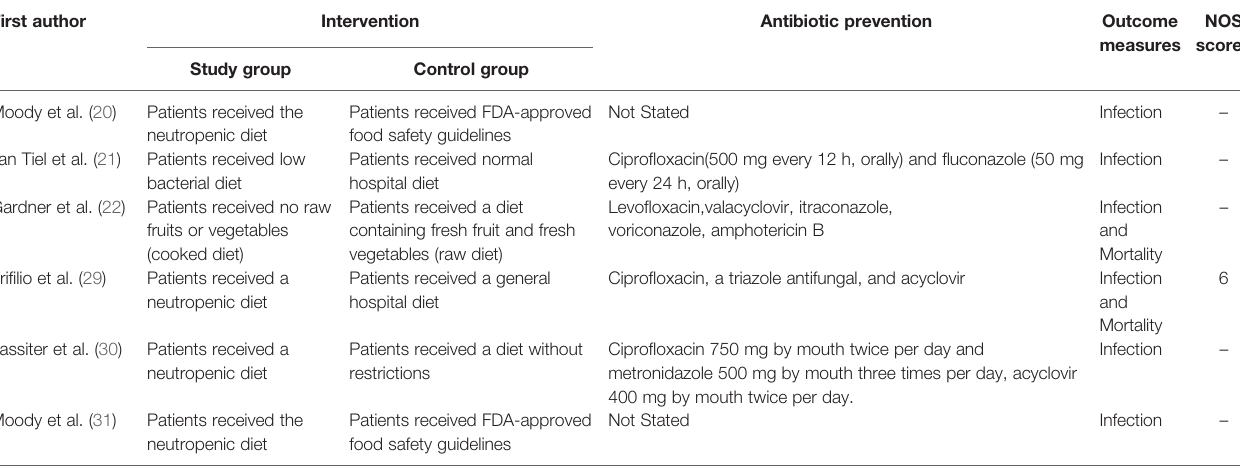
TABLE 2 | The intervention and the outcome of all included studies.